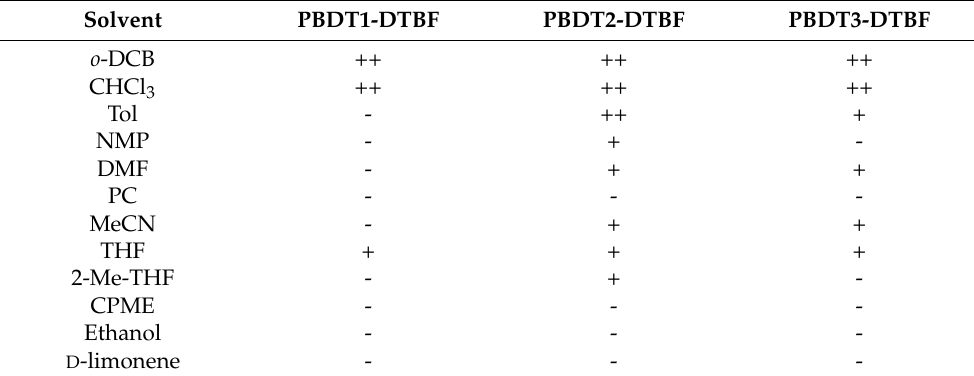
Table 2. Solubility of polymer PBDT1-DTBF, PBDT2-DTBF and PBDT3-DTBF.